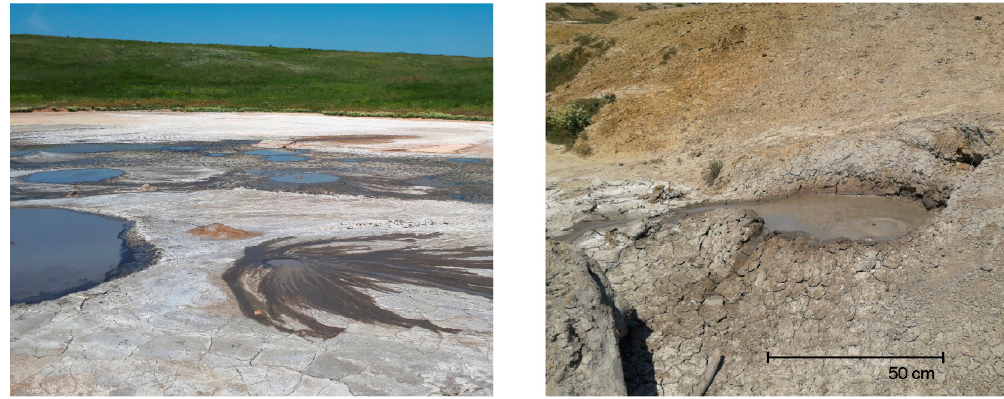
Figure 1. Field images of the Bulganak mud volcano area ( left ) and the studied mud volcano ( right ). Table 1. Physical and chemical characteristics of the water extracted from the mud sample.